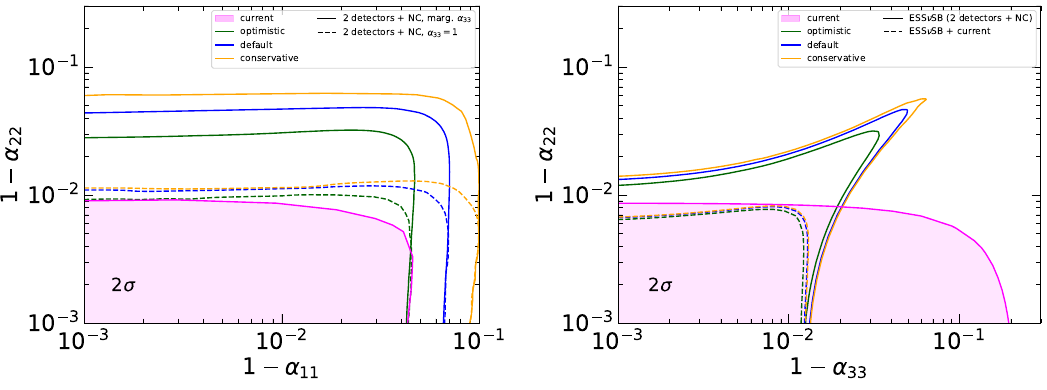
Figure 5 . Left: Comparison of the ESS ν SB sensitivities in the (1 − α 11 ) − (1 − α 22 ) plane obtained marginalizing over α 33 (solid lines) and keeping α 33 = 1 fixed (dashed lines). The dashed lines in this figures are the same as the solid lines in figure 4. Right: The bounds in the (1 − α 33 ) − (1 − α 22 ) plane than can be obtained from an analysis of ESS ν SB data alone and from a combined analysis with the current bounds. In both panels we also show the current bounds taken from ref.